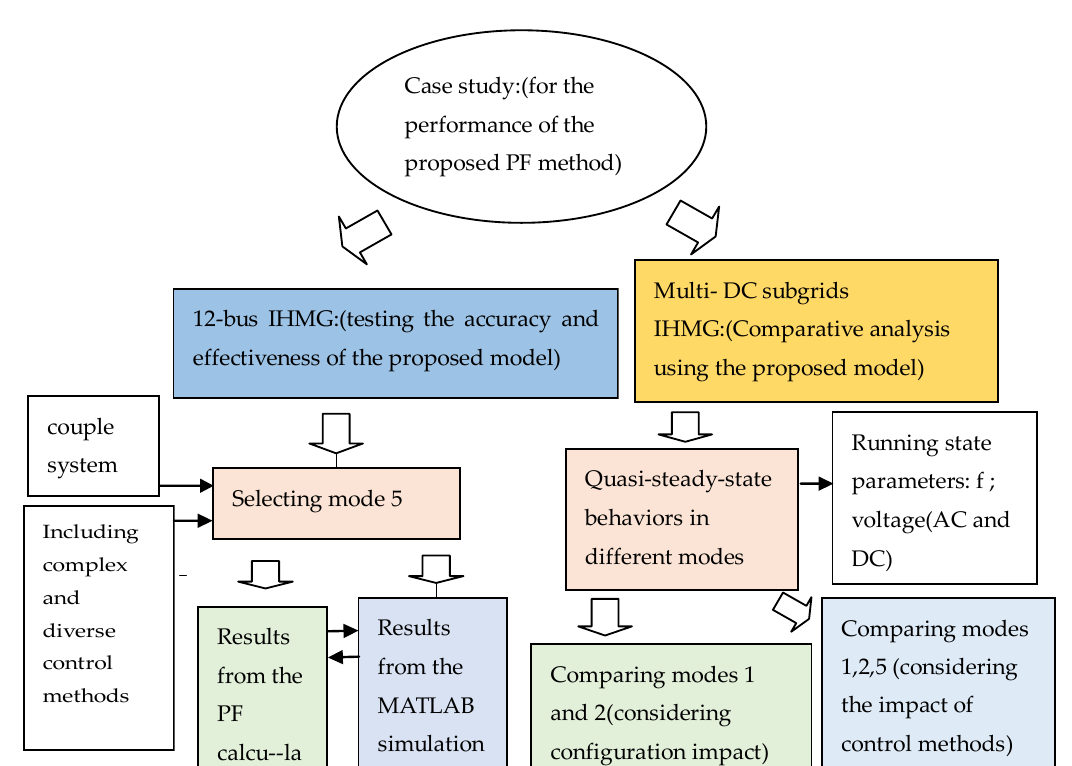
Figure 4. The schematic overview of case studies.